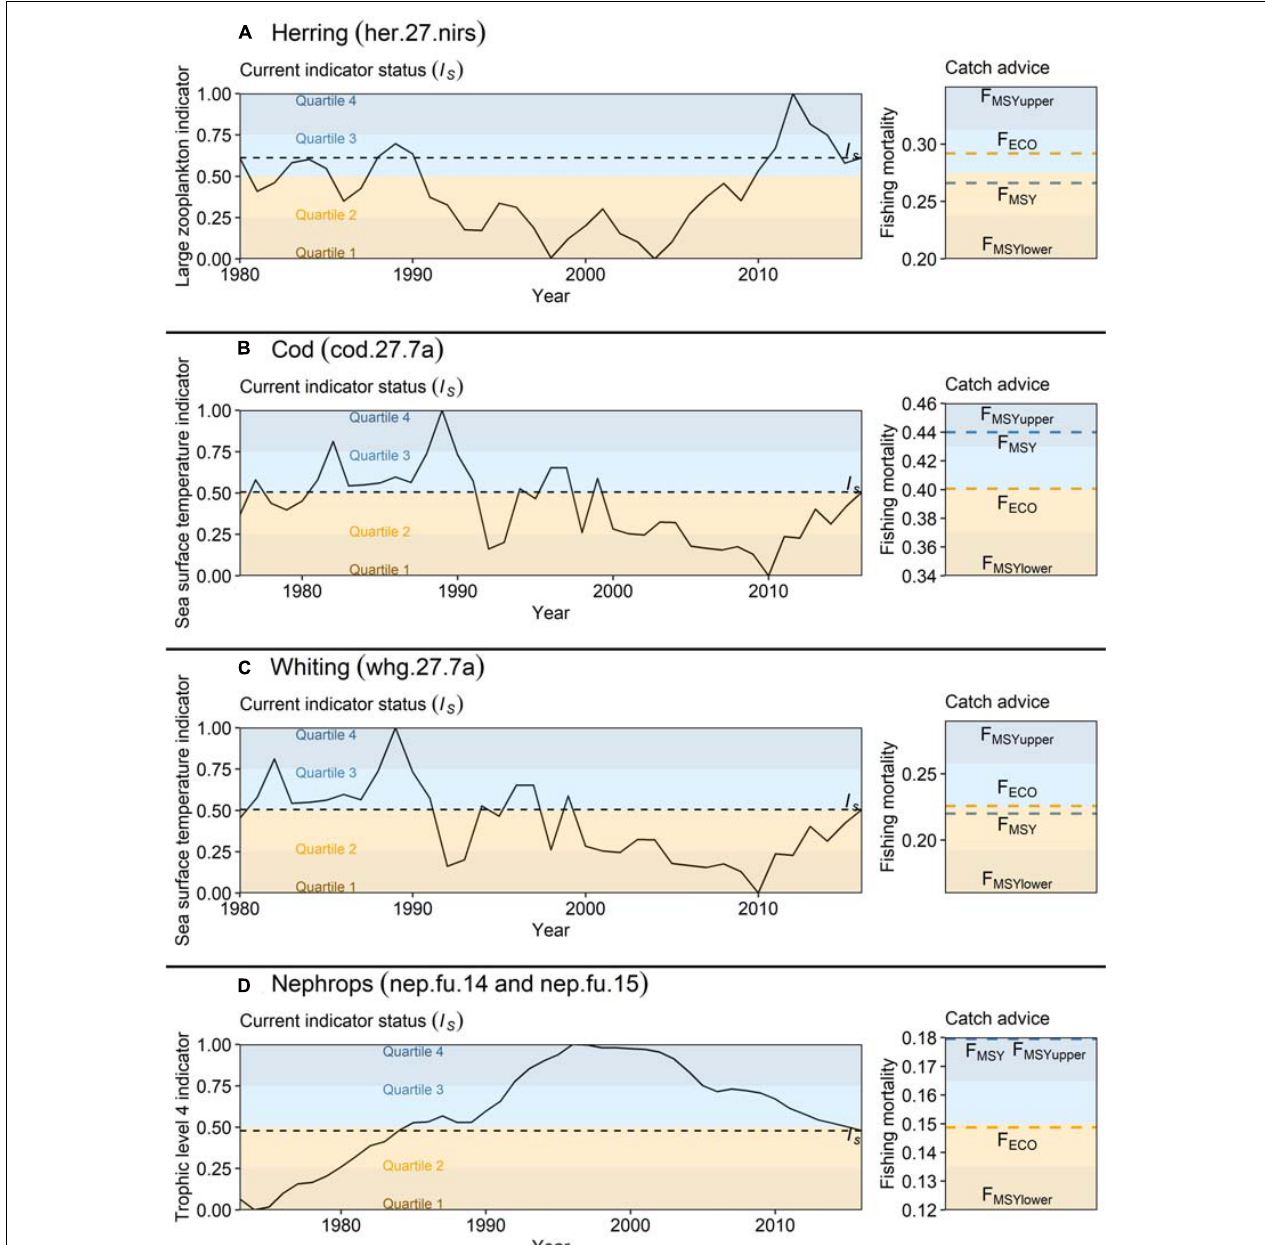
FIGURE 5 | From indicator to F ECO . Examples are presented for Irish Sea (A) herring with large zooplankton biomass as an indicator, (B) cod with inverted sea surface temperature (SST; 3-year lag) as an indicator, (C) whiting with SST (3-year lag) as an indicator, and (D) Nephrops with the inverted biomass of trophic level 4+ as an indicator. On the left, all indicators are rescaled between zero and one to provide a percentile value which ranks the status of the indicator (I S ) in 2016 compared with previous years. On the right, the status of the indicator determines the placement of the F ECO reference point within ICES F MSY